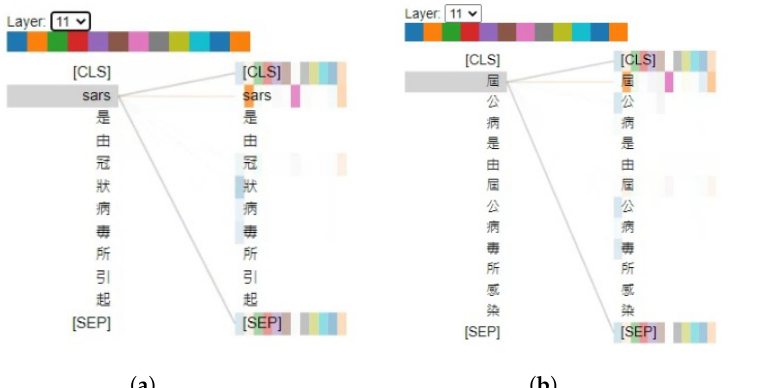
Figure 4. Visualization of attention between disease name and virus: ( a ) SARS is caused by the coron- avirus; and ( b ) chikungunya is caused by chikungunya